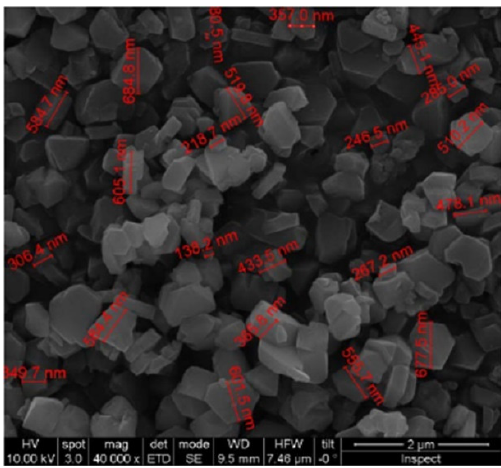
Figure 5. SEM images of the CBV100 crystals used for the functionalization of the cantilevers.